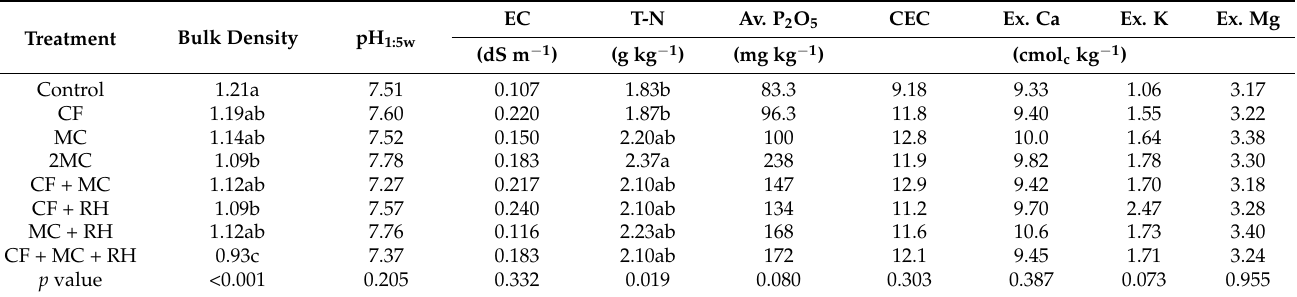
Table 3. Physicochemical properties of soils treated with different type of soil amendments.